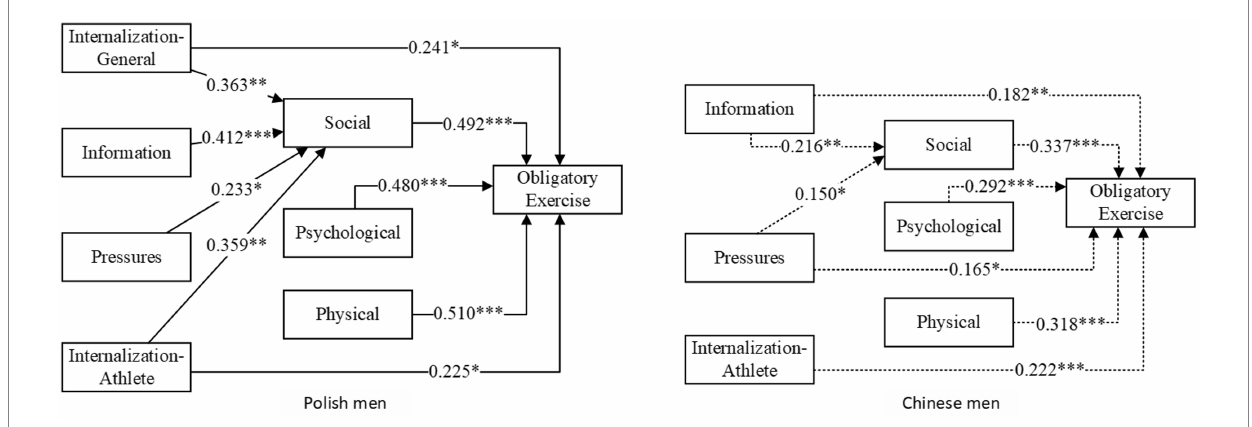
FIGURE 1 Sociocultural attitudes about the body (Internalization-General, Information, Pressures, and Internalization-Athlete) and motivation for physical activity (Physical, Psychological, and Social) as predictors of obligatory exercise among young Polish and Chinese men. Non-standardized estimates are presented; # p < 0.05, ** p < 0.01, *** p < 0.001: to improve the readability of the presentation. Only paths with significance levels < 0.05 were retained.